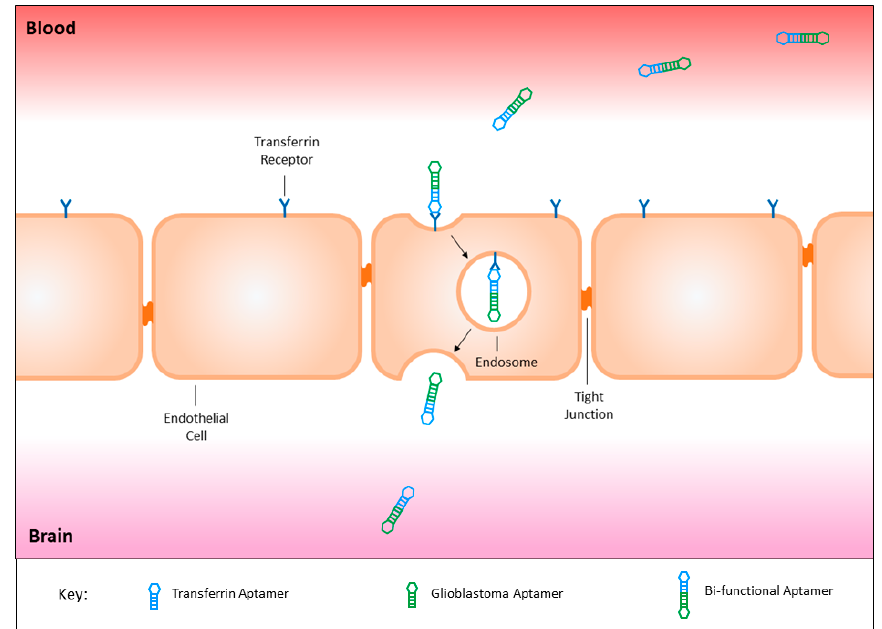
Figure 2. The fusion of a transferrin aptamer with a glioblastoma targeting aptamer would create a bi-functional aptamer capable of crossing the blood brain barrier to target glioblastoma tumour tissues specifically. This targeted mechanism may be utilised for the safe delivery of both imaging and therapeutic agents, sparing healthy cells throughout the body and the surrounding brain tissues from off-target effects.